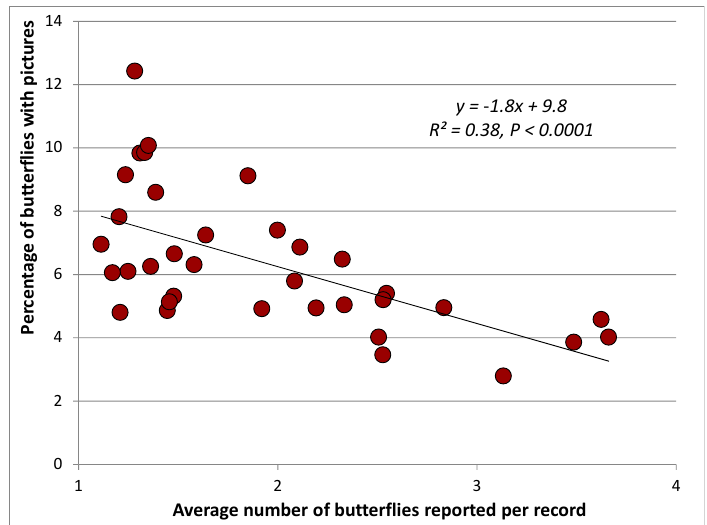
Figure A4. Relation between the average number of peacock butterflies in Belgium per record submitted (a measure of abundance) (by week, for weeks 10–44) and the percentage of the butterflies reported that are also illustrated with pictures.